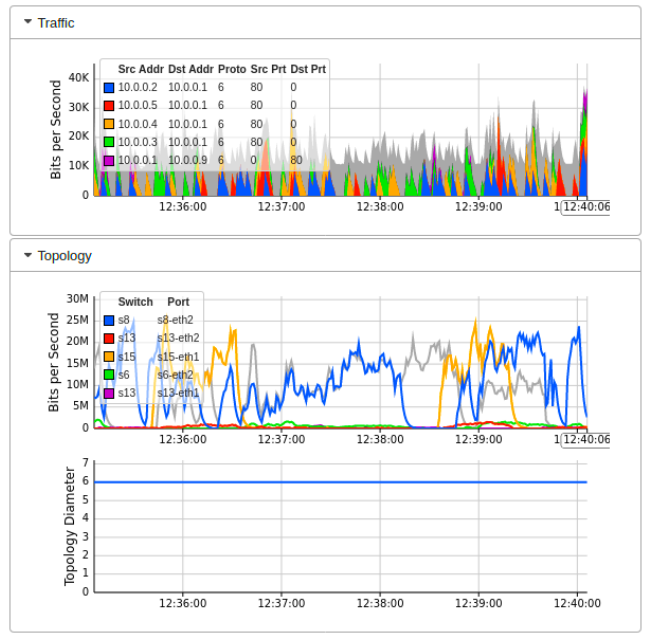
Figure 10. Mininet performance dashboard during real-time DDoS attacks (T1).